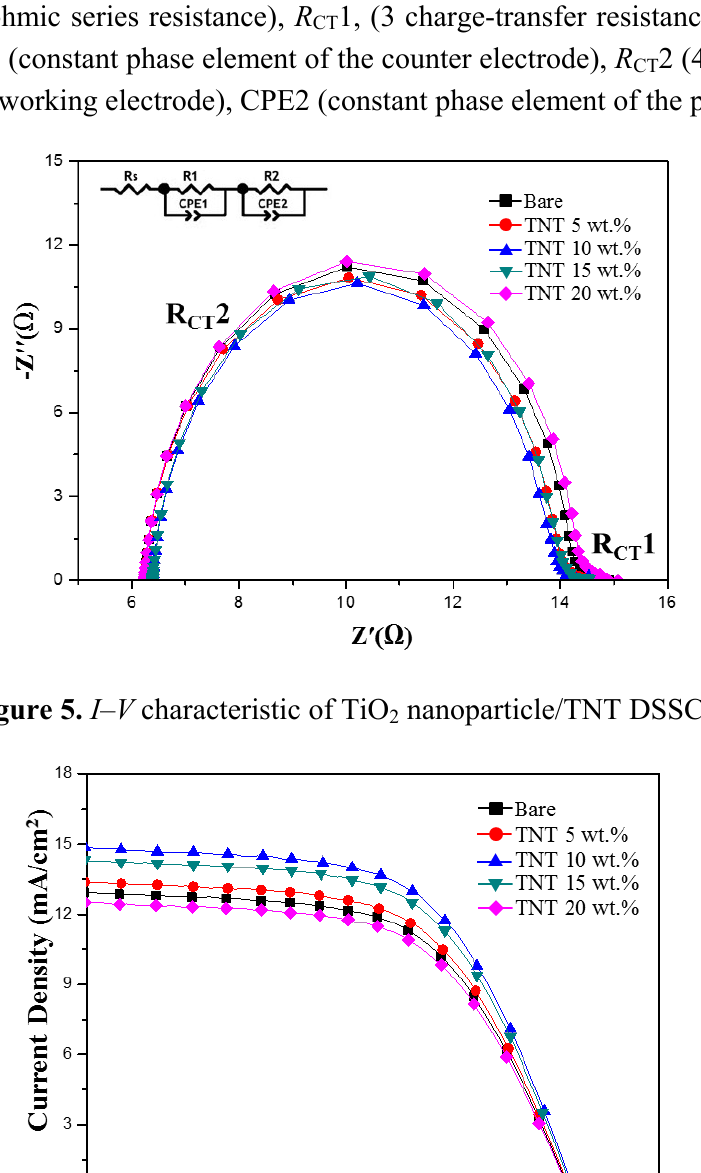
Figure 4. Electrochemical impedance spectroscopy (EIS) Nyquist plots of DSSCs with TNT mixed TiO films of different TNT concentrations. The following abbreviated terms 2 were used: R s (ohmic series resistance), R 1, (3 charge-transfer resistance of the counter CT electrode), CPE1 (constant phase element of the counter electrode), R 2 (4 charge-transfer CT resistance of the working electrode), CPE2 (constant phase element of the photoelectrode).